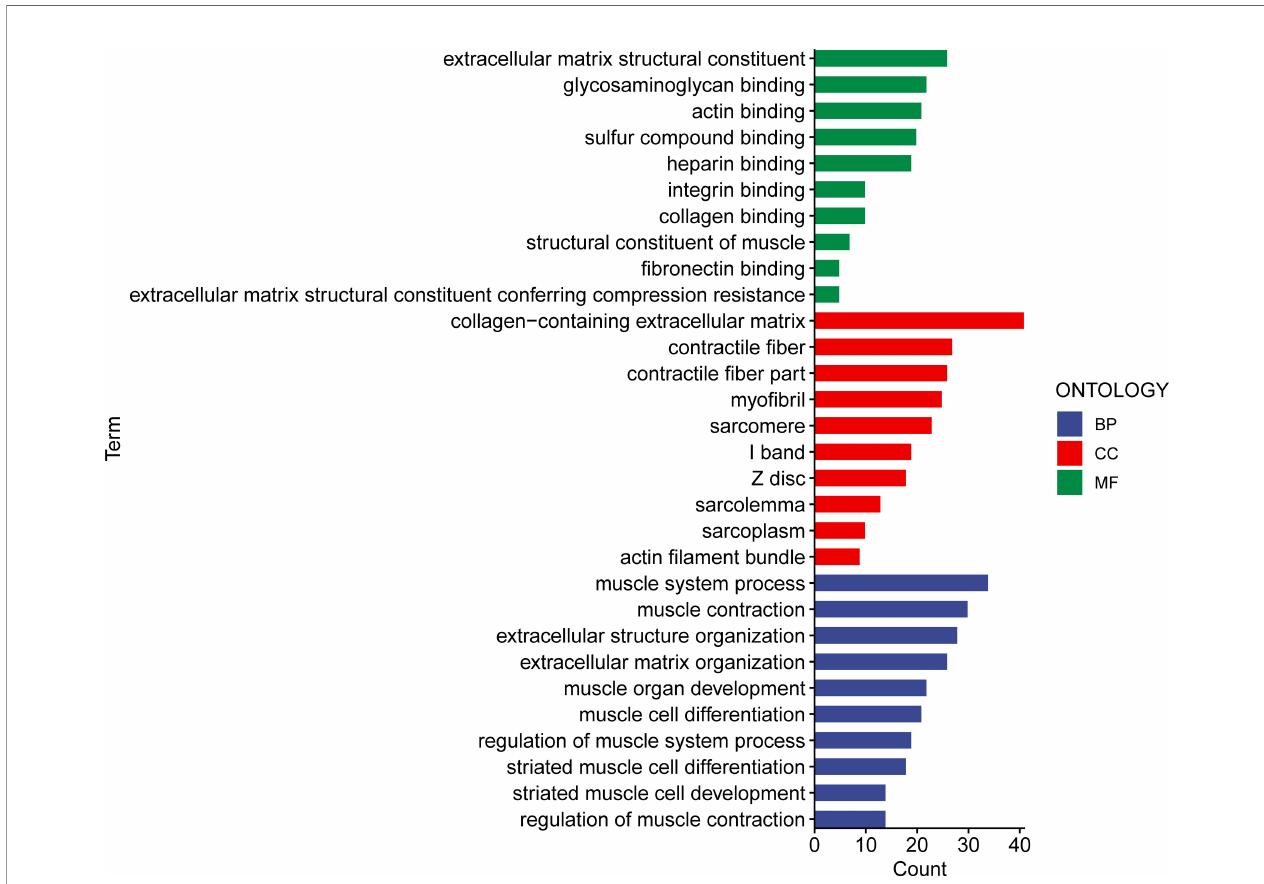
FIGURE 9 | The GO enriched pathways in the different risk subsets obtained from the 15 matrisomal-related lncRNA-based